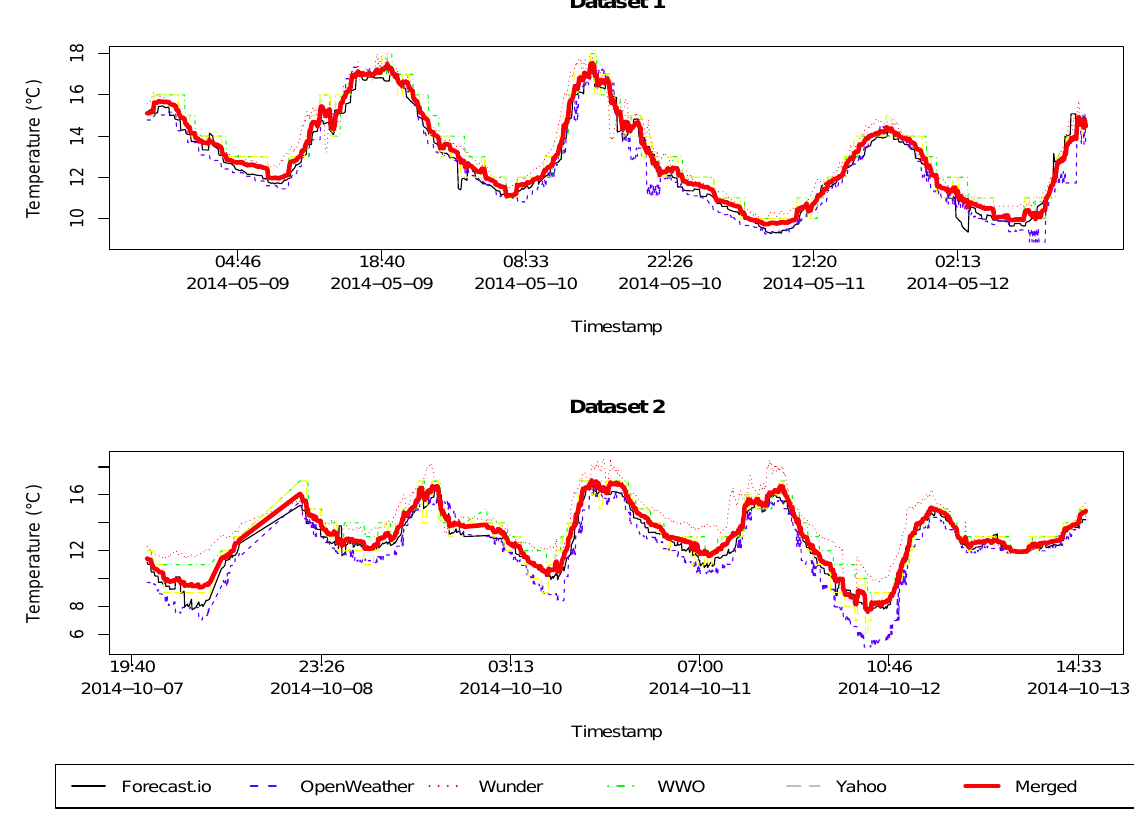
Figure 1. Comparison between five possible reference services and the average merged sample, for the two